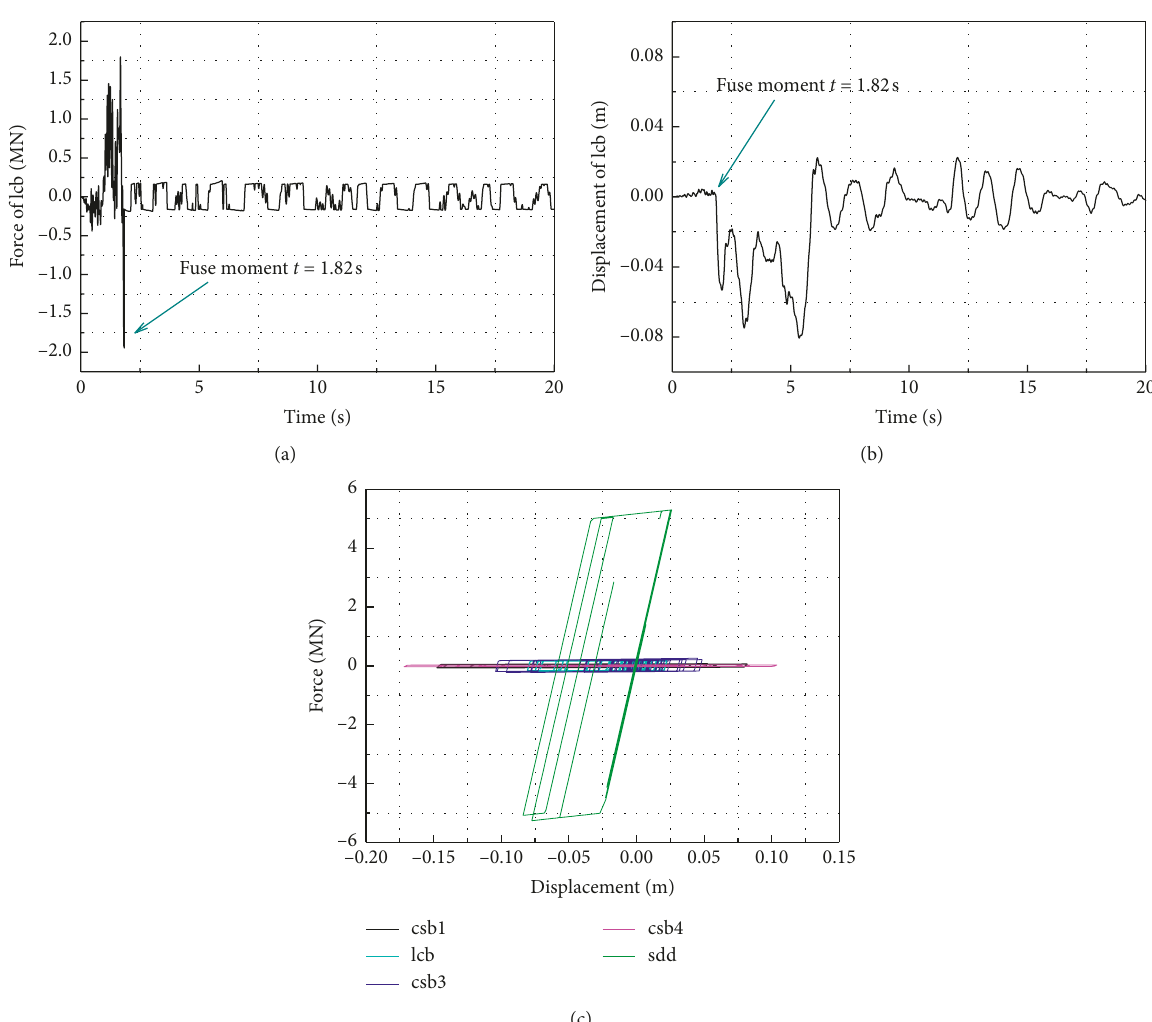
Figure 22: Seismic response of the bridge after the addition of a 5000kN yield force steel damping device. (a) The shear force of the limited capacity bearing. (b) Displacement of the limited capacity bearing. (c) Force versus displacement of the bearing and energy dissipation limiting